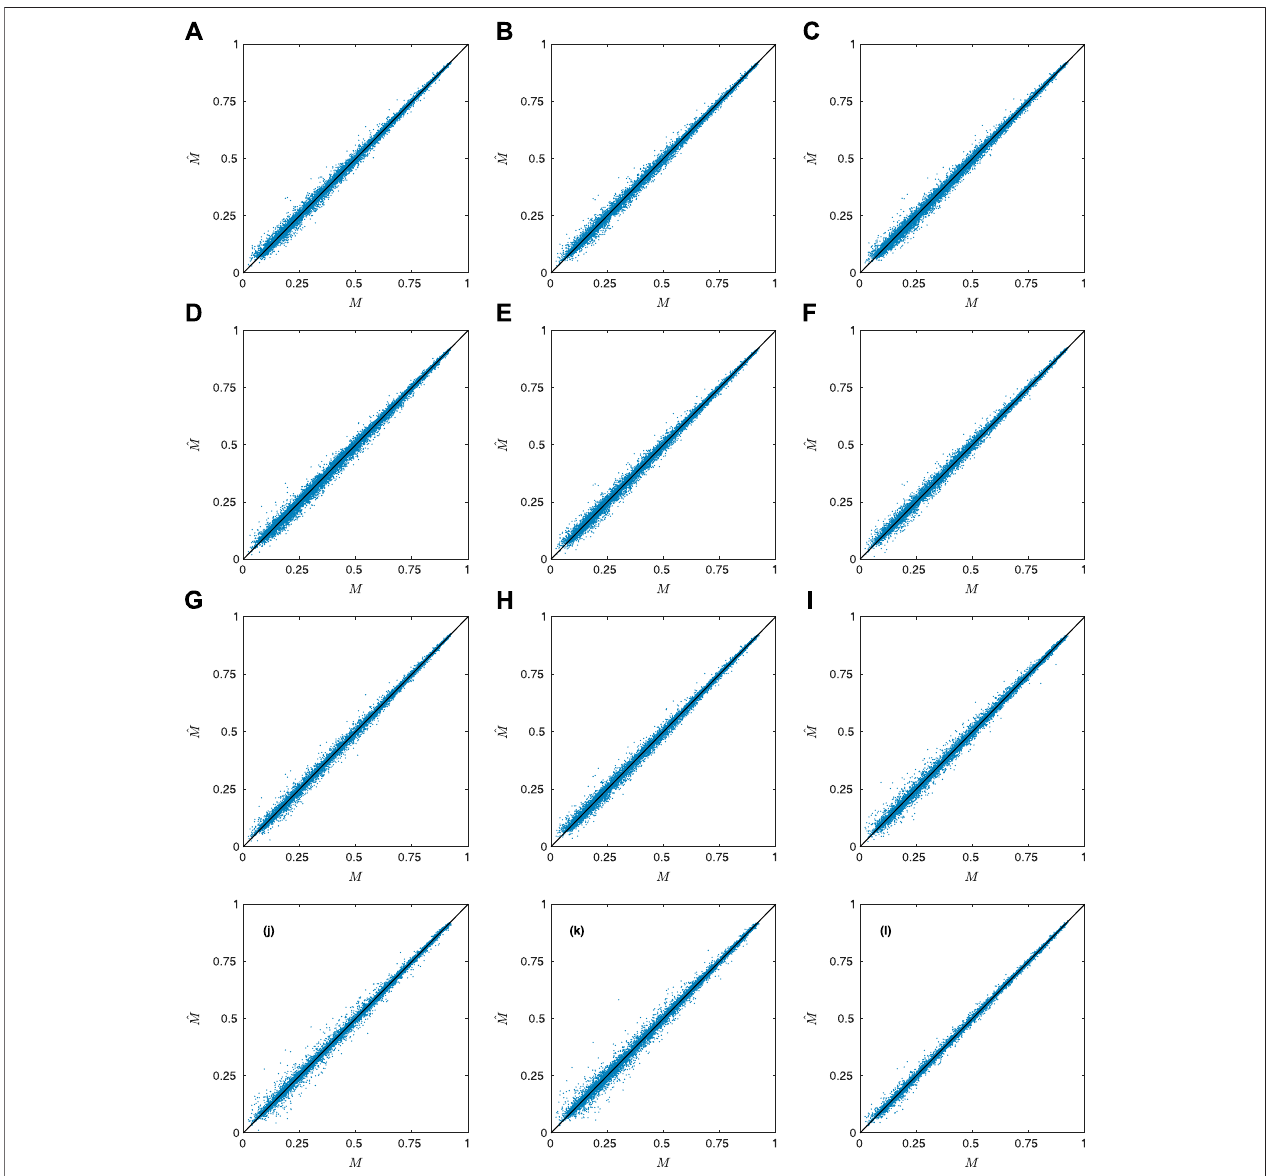
FIGURE 5 | Prediction of M-factor using ANNs. Top row (from left to right): Prediction of M via Models 1 – 3. Second row (from left to right): Prediction of M via Models4 – 6.Thirdrow (fromlefttoright): Predictionof M viaModels7 – 9.Bottomrow (fromlefttoright): Predictionof M viaModels10 – 12.Notethatthescatterplots show results based on the test